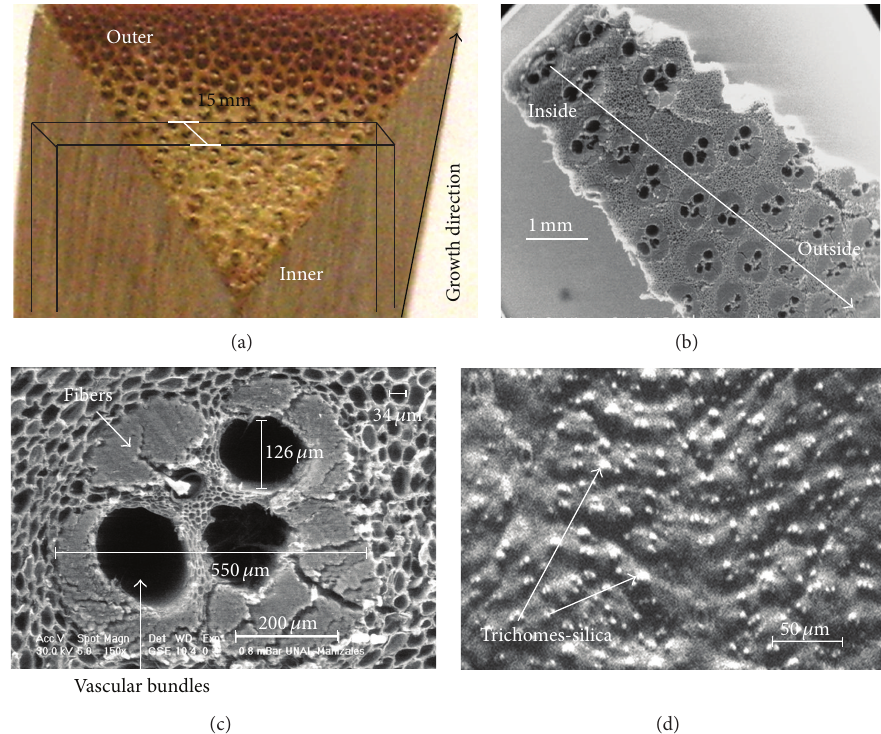
Figure 2: Micrographs of the GAKVB culm: (a) radial section, (b) distribution of vascular bundles, (c) fibers and vascular bundles, and (d) Trichomes silica in the surface of the GAKVB.